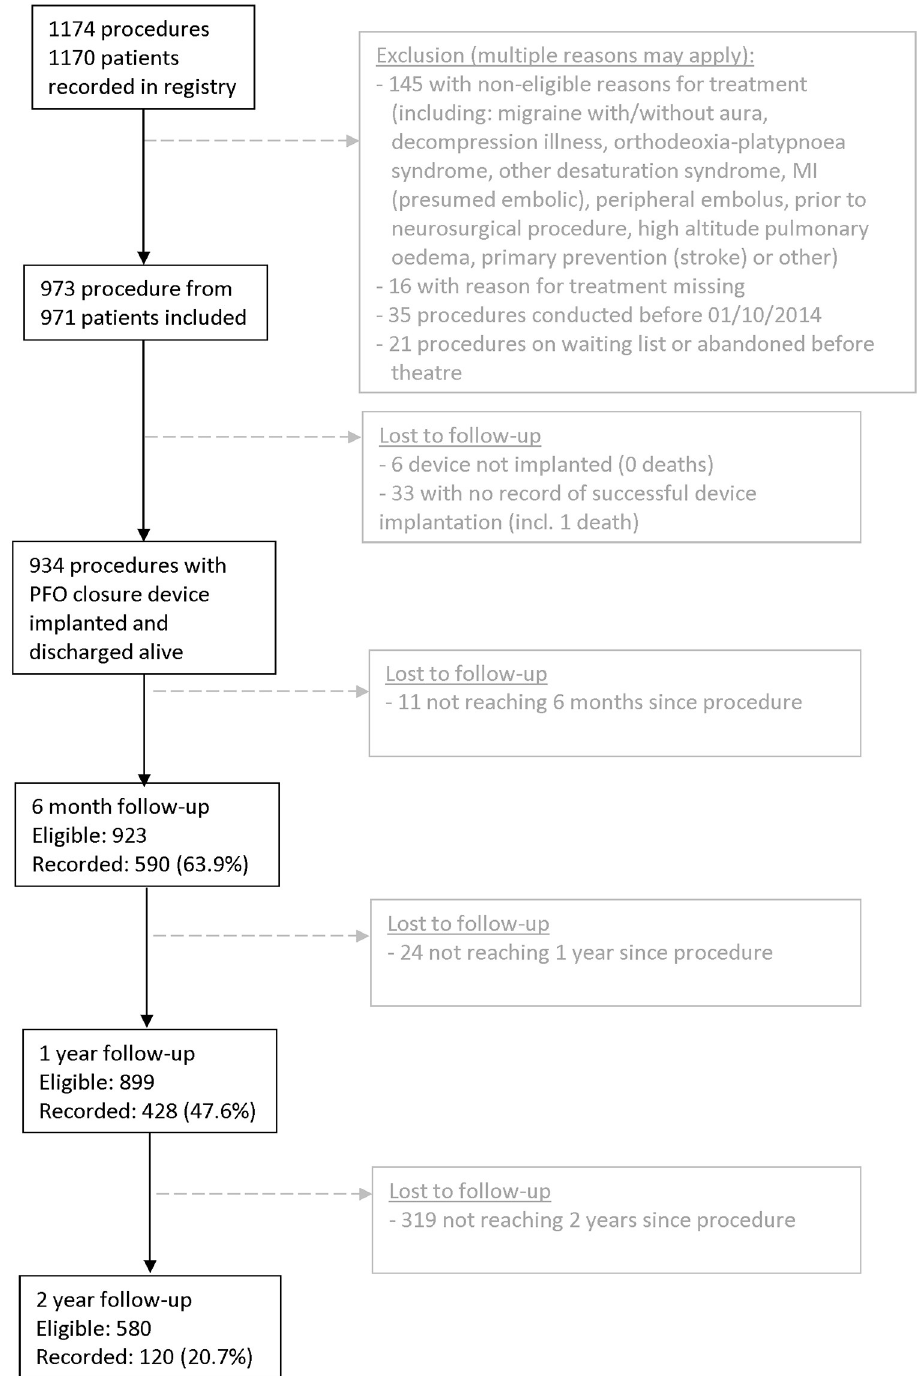
Fig 1. Patient flow in the CtE registry. Outcomes (stroke, death, TIA) were derived from data linkage.